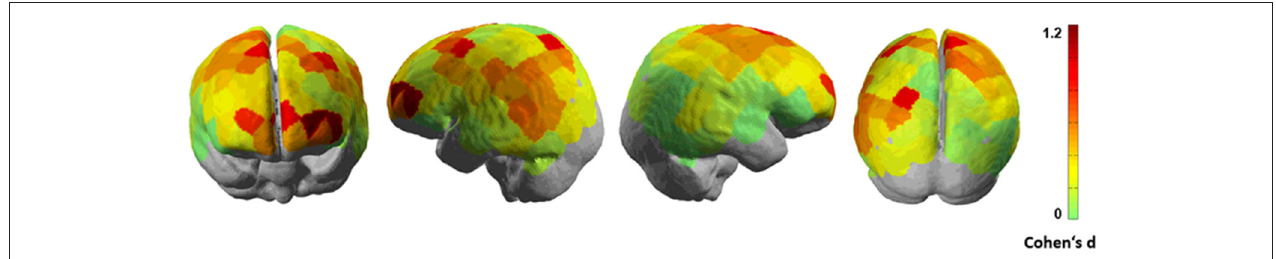
FIGURE 5 | Cohen’s d brain maps representing effect sizes computed from channel-wise weighted averaged t-statistics (t avg ) for the group-level analysis. Moderate to high Cohen’s d values (0.8–1.2) show medium to large effect sizes indicating increased activation differences for the decision-making phase during turning in front of AV as compared to